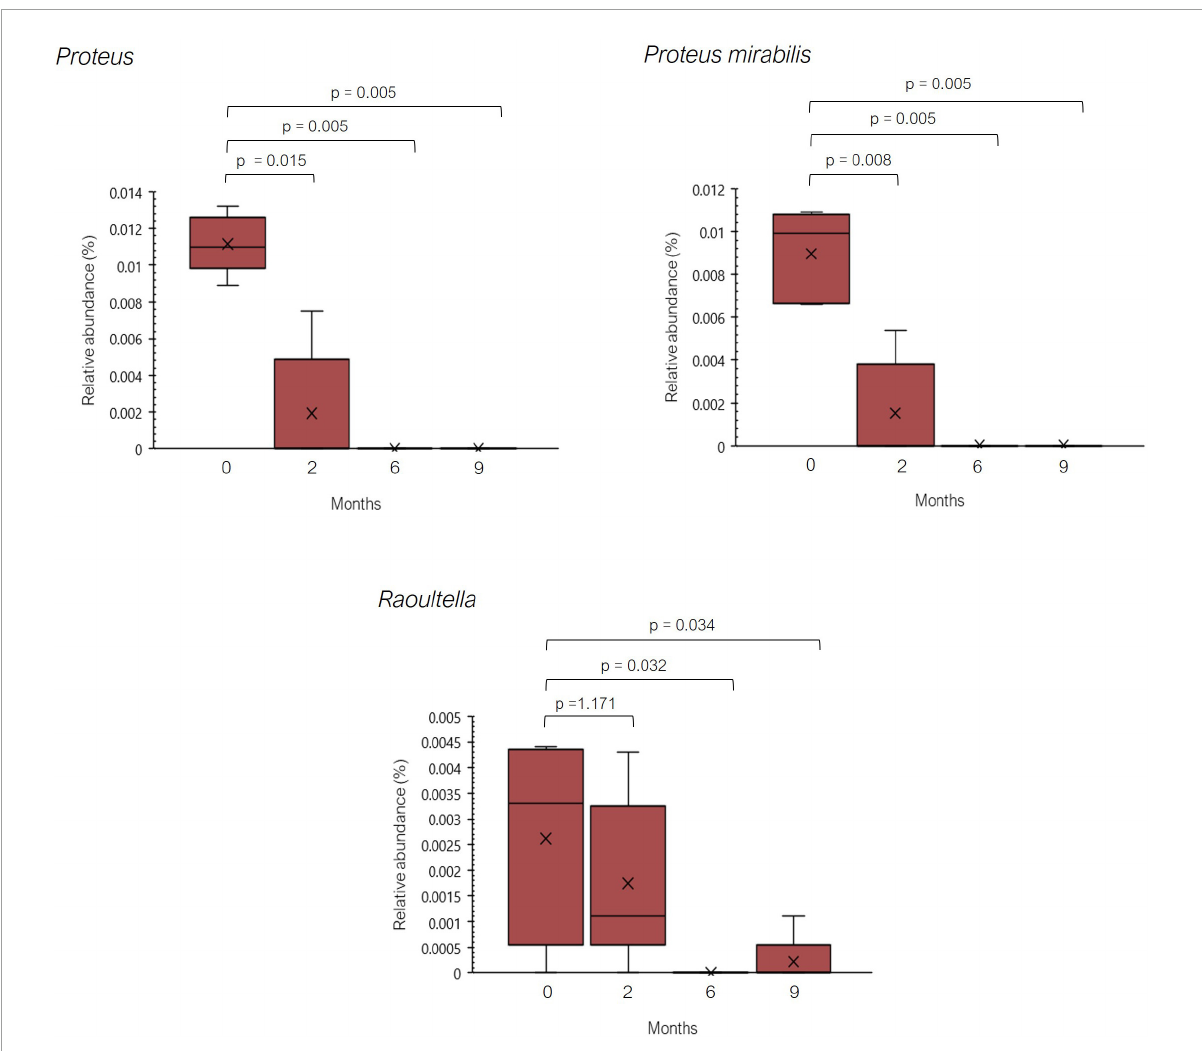
FIGURE5 Relative abundance (%) of Proteus , Proteus mirabilis, and Raoultella observed in histamine intolerant patients during the dietary management. Mean values are represented with an × . p < 0.05 indicates statically significant